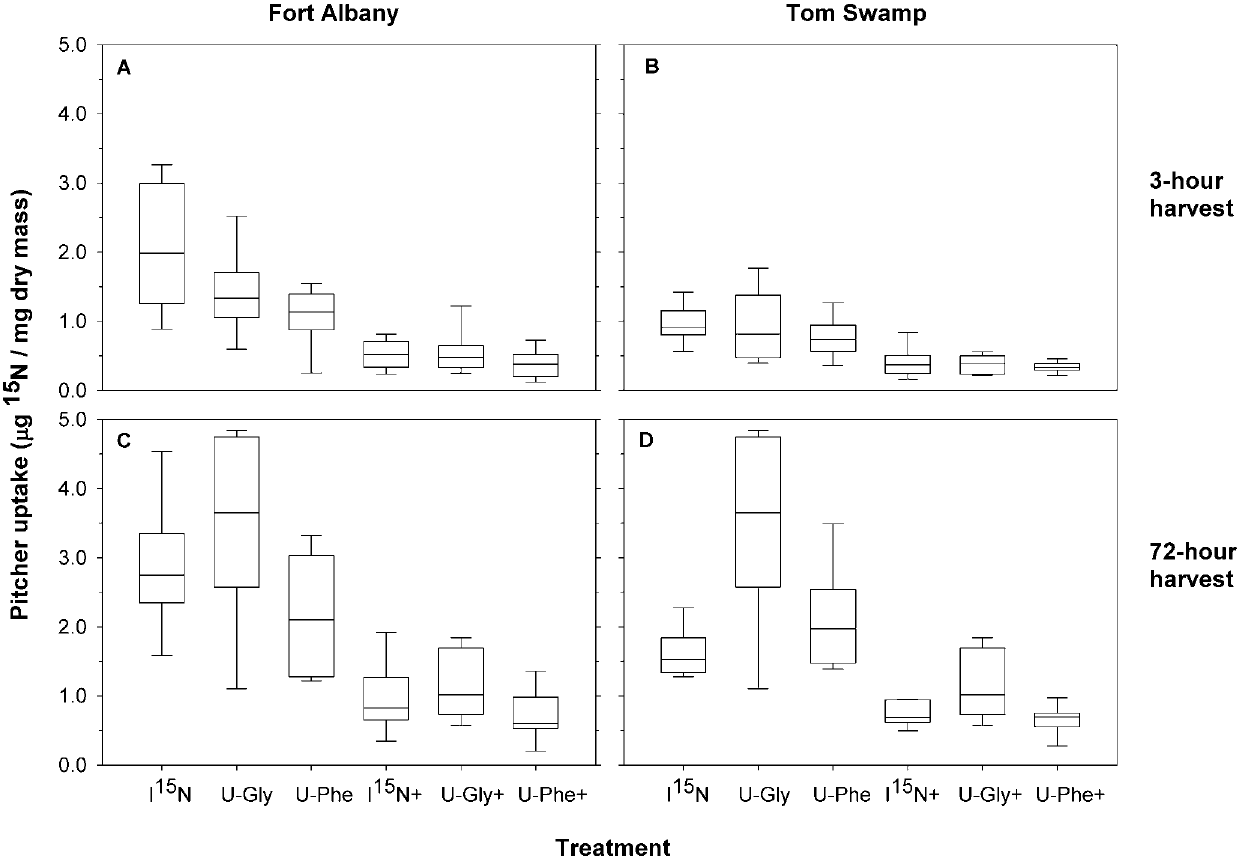
Figure 4. 15 N acquisition by Sarraceniapurpurea pitchers supplied with multiple forms of nitrogen. Nitrogen was provided to pitcher leaves as ammonium nitrate ( 15 NH 415 NO 3 ), uniformly-labeled (U-) 13 C- 15 N-glycine or U- 13 C- 15 N-phenylalanine ( IN , U-Gly , and U-Phe , respectively) or in combination ( IN + , U-Gly + , U-Phe + , respectively) at Fort Albany, Ontario, Canada (left, panels A, C ) and at Tom Swamp, Massachusetts, U S A (right, panels B, D ). Uptake was measured after 3 hours (top, panels A, B ) and 72 hours (bottom, panels C, D ) in a pulse-chase experiment. The total amount of N provided to pitchers at Fort Albany was 0.022 mg, and was 0.101 mg N at Tom Swamp. Pitchers with and without the invertebrate food webs were pooled for these analyses because there were no significant differences in 15 N uptake in the two food-web treatments (Fort Albany F 1,96 =0.137, P =0.71; Tom Swamp F 1,94 =1.68, P =0.20).